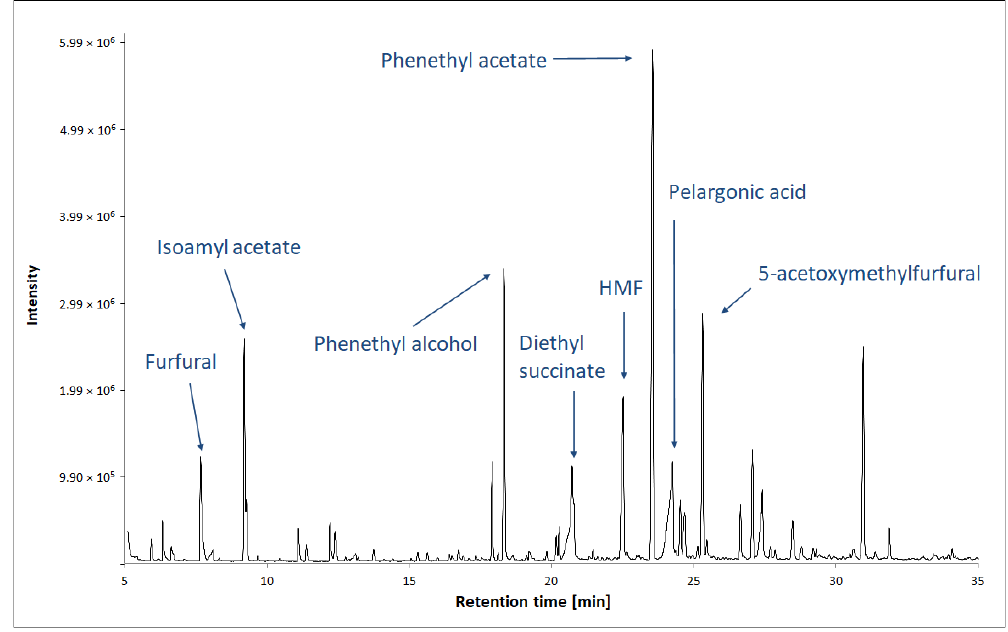
Figure 4. Analysis of VOCs in TBV by GC-MS method. Figure adapted from